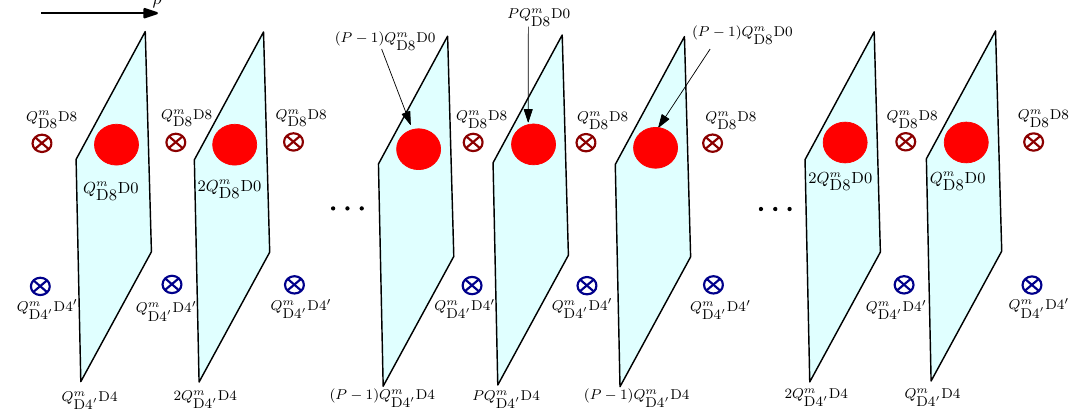
Figure 5 . The Hanany-Witten like brane set-up for the completed non-Abelian T-dual solution, underlying the quiver depicted in figure